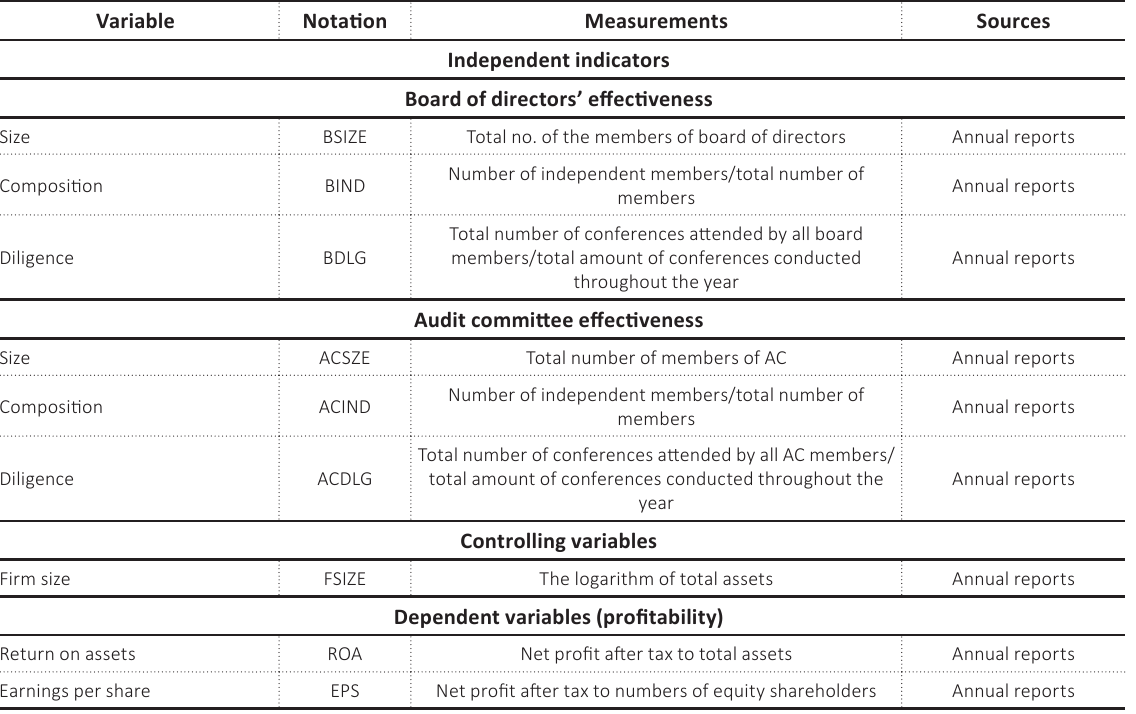
Table 1. Measurement of